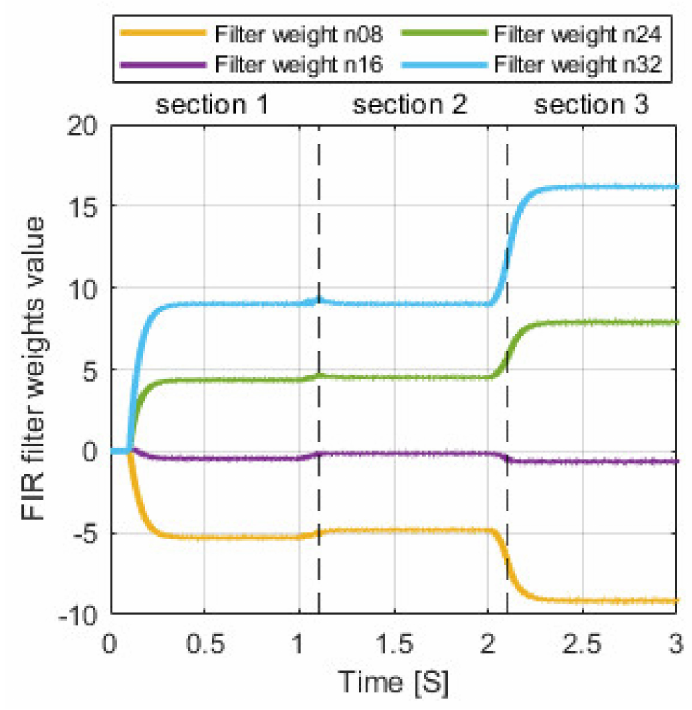
Figure 17. Simulation cycle 2: weight trend in FIR discrete filter.